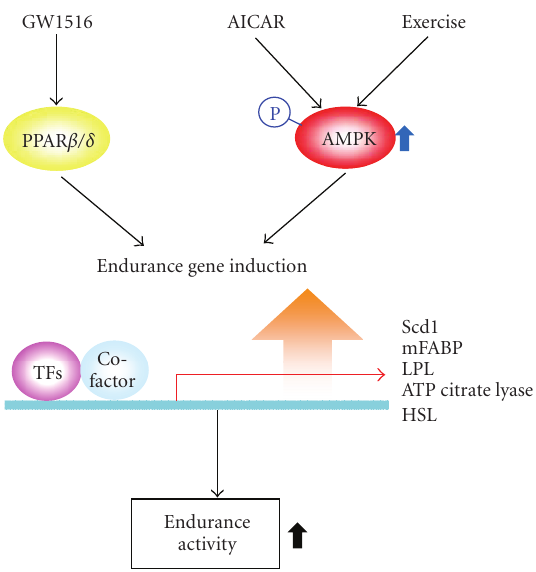
Figure 3: The e ff ects of PPAR β/δ activators on AMPK-dependent functions. AICAR: aminoimidazole carboxamide ribonucleotide; TFs: transcription factors.